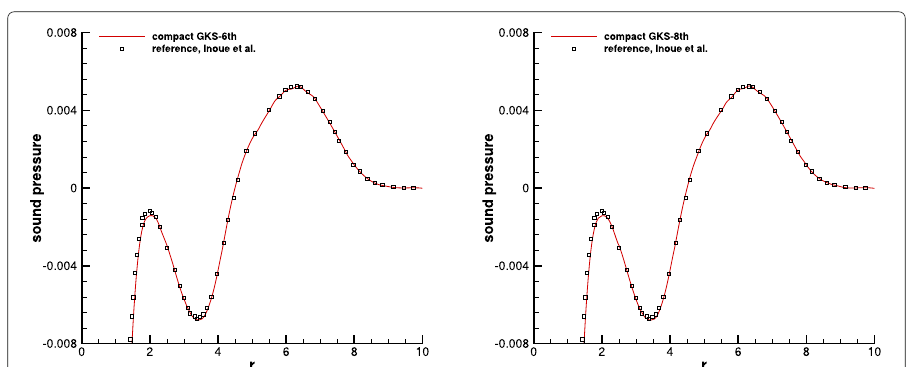
Fig. 20 Two-dimensional acoustic problem: radial distribution of the sound pressure (cid:15) p obtained by 6th-order and 8th-order compact GKS at t = 6 with 700 × 600 mesh points. The vortex center at t = 6 is approximately located at ( − 3.9,0.0